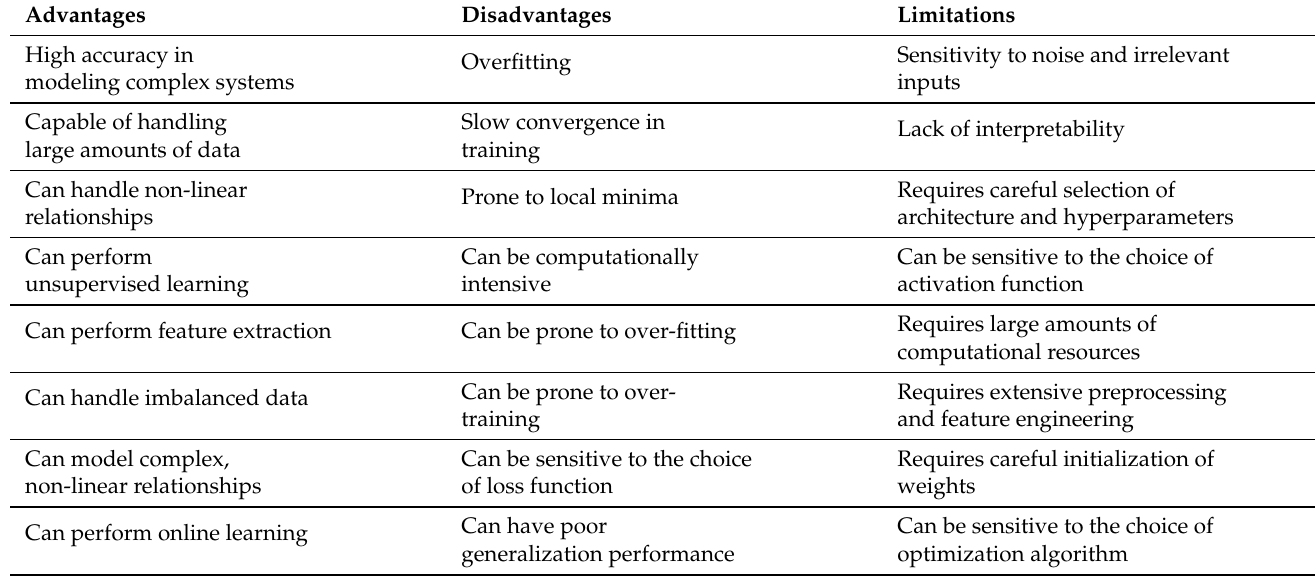
Table 1. Advantages, Disadvantages, and Limitations of ANN-based